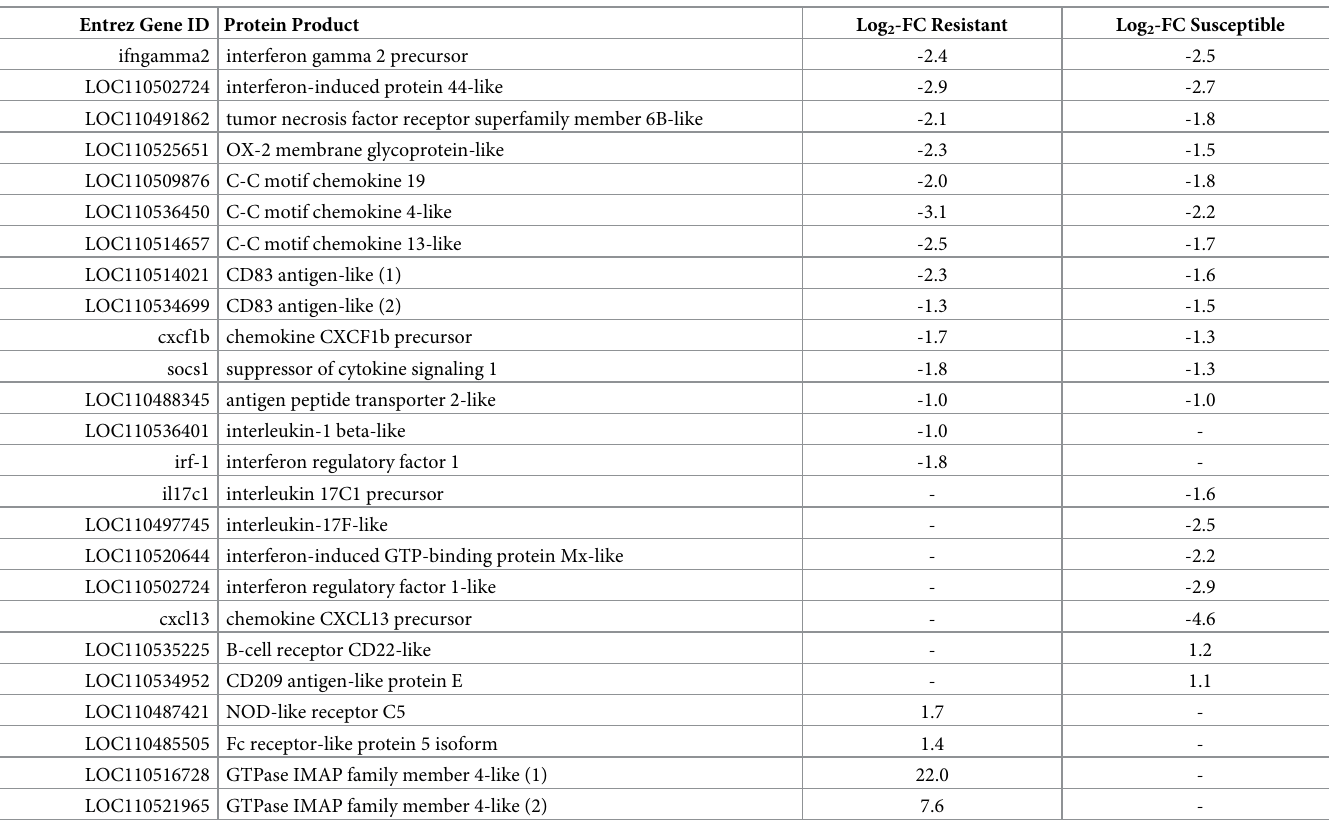
Table 3. Select immune genes that were differentially expressed in the gills of resistant and susceptible steelhead at 1 day post exposure to Ceratonova shasta . Entrez Gene ID Protein